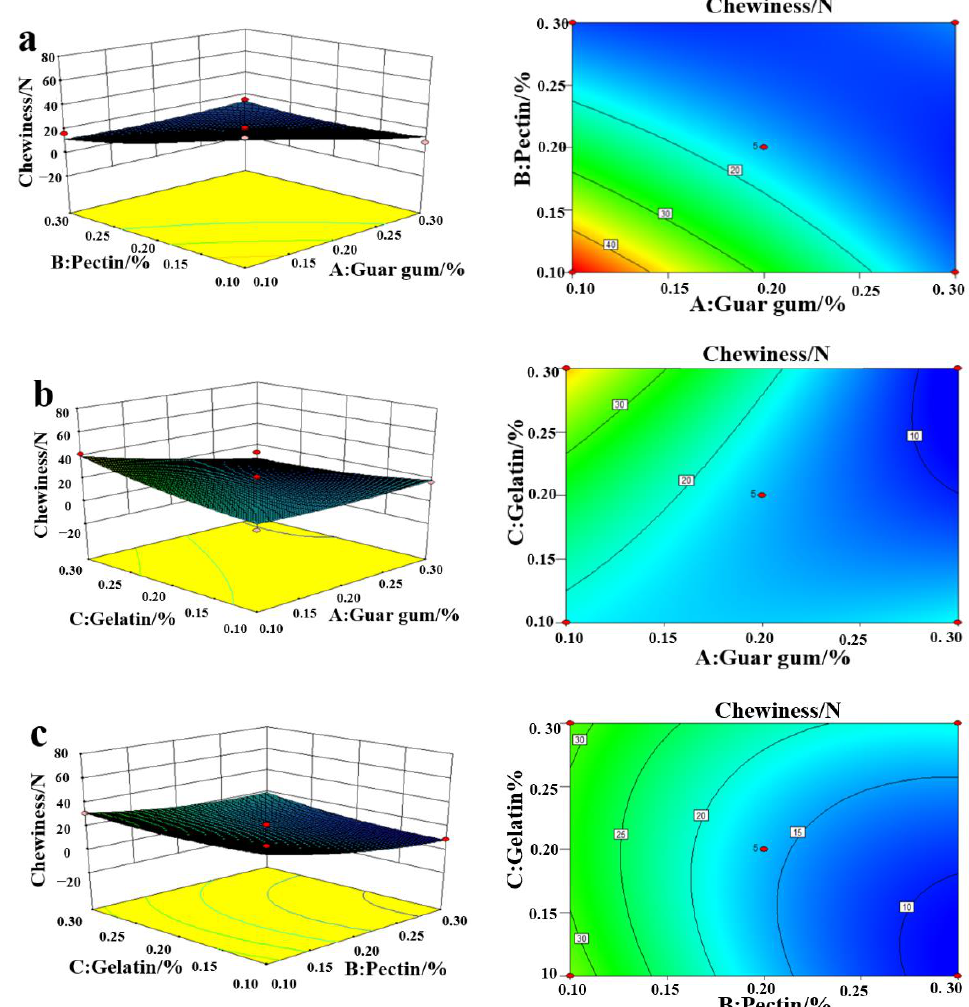
Figure 1. Response surface methodology of the interaction between guar gum and pectin ( a ), guar gum and gelatin ( b ), and pectin and gelatin ( c ) to chewiness.